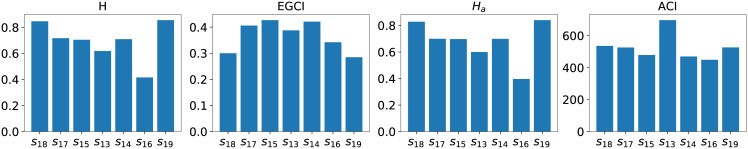
Values of the three indices, ACI, Ha, EGCI, and the entropy of the eigenvalues H, for the reference samples.These values were obtained using a time lag (τ) and an FFT with 512 points.